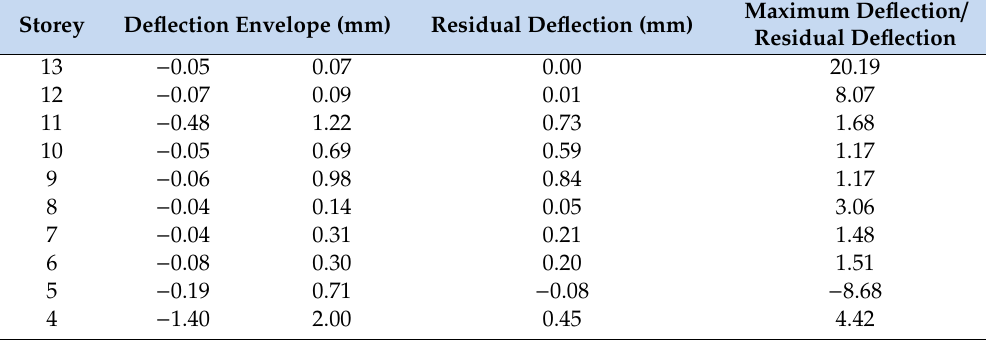
Table 9. KHC and IHC deformation results for whole building with slab model in ULS case.